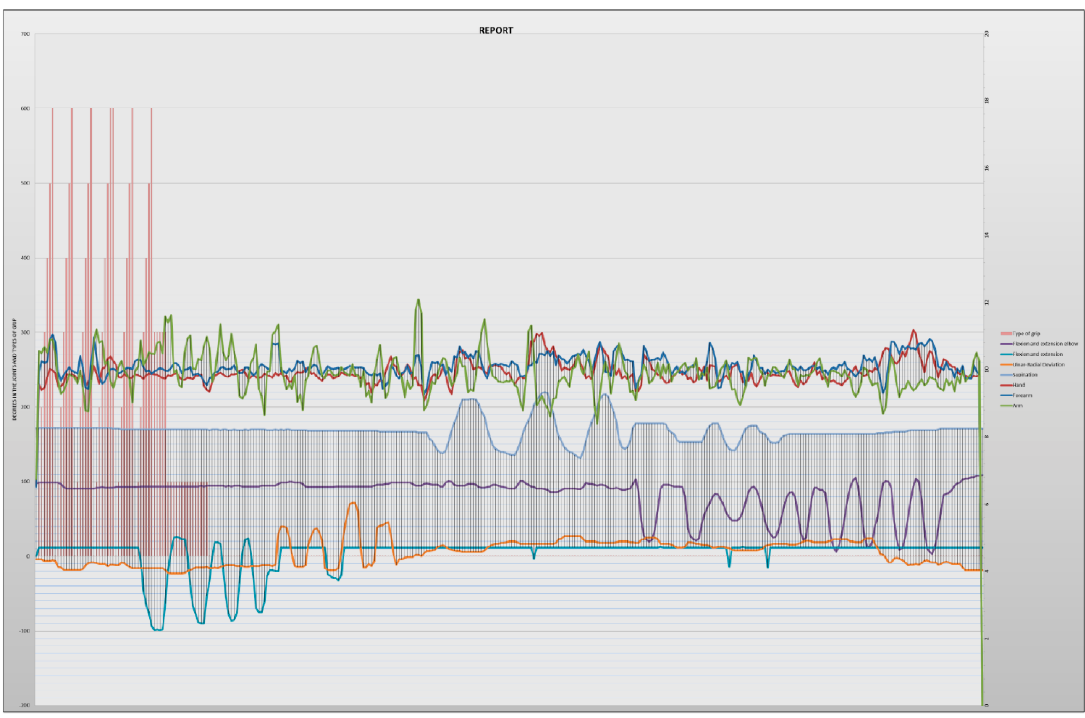
Figure 13. Graph obtained from the report.